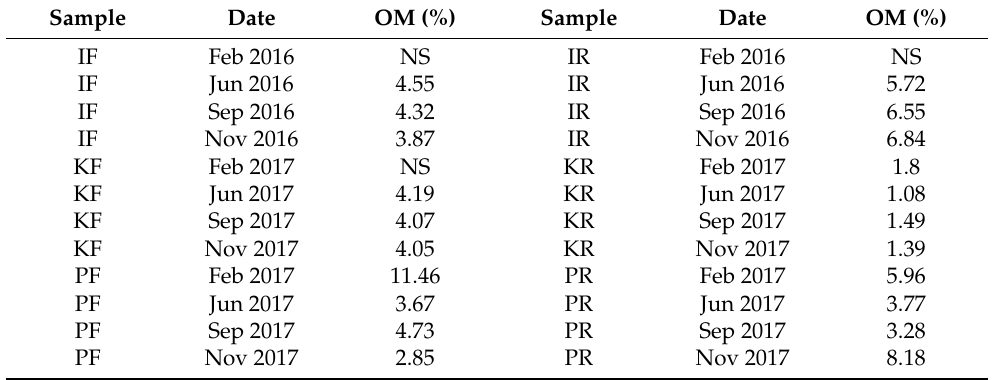
Table 6. Summarized OM content in sediment samples from all studied locations and all sampled